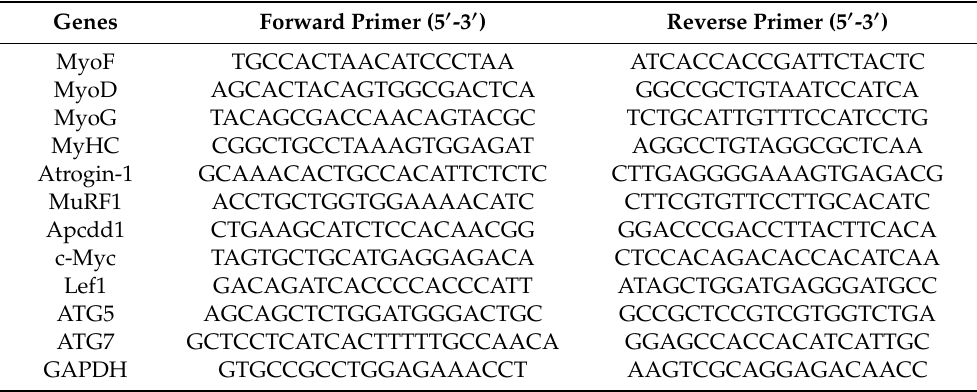
Table 1. Primers used for quantitative real-time PCR